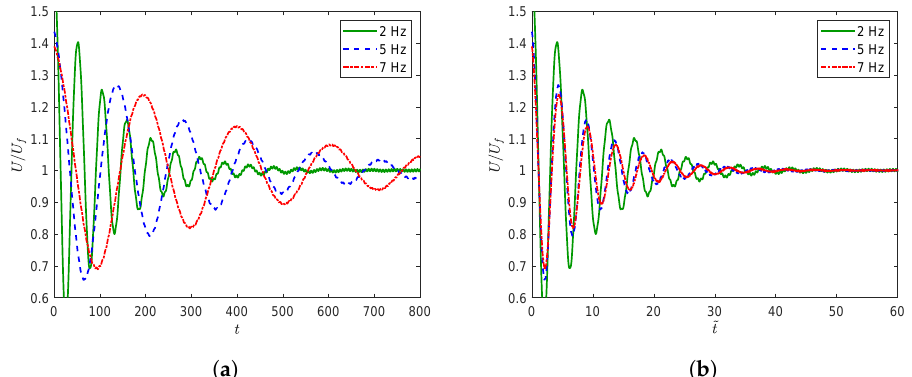
Figure 2. Transient phase of non-dimensional velocity U for three different frequencies. ( a ) Normal- ized velocity vs. non-dimensional time; ( b ) normalized velocity vs. time in seconds.